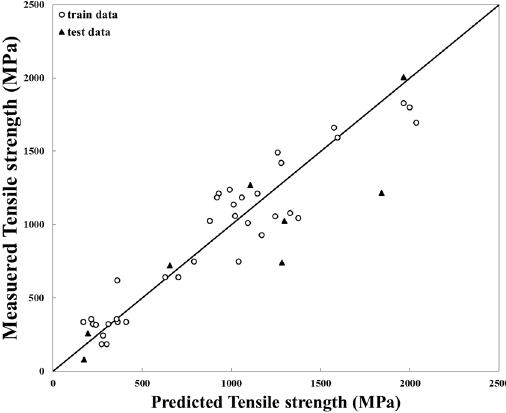
Figure 4. Accuracy of a lasso model trained with elemental mole fraction and process data.